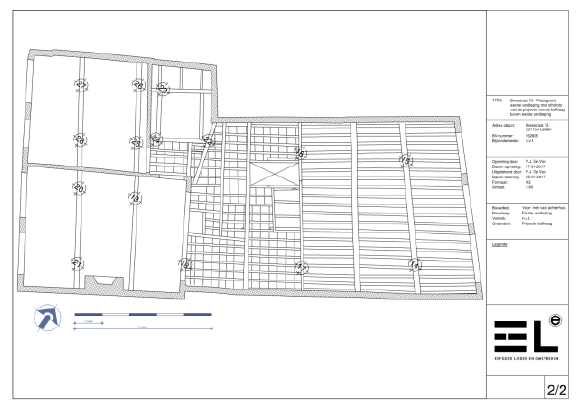
Figure 10. Floor construction, traced from orthophoto. Plan generated using a Total Station connected to a tablet with BricsCAD. (Breestraat 73,